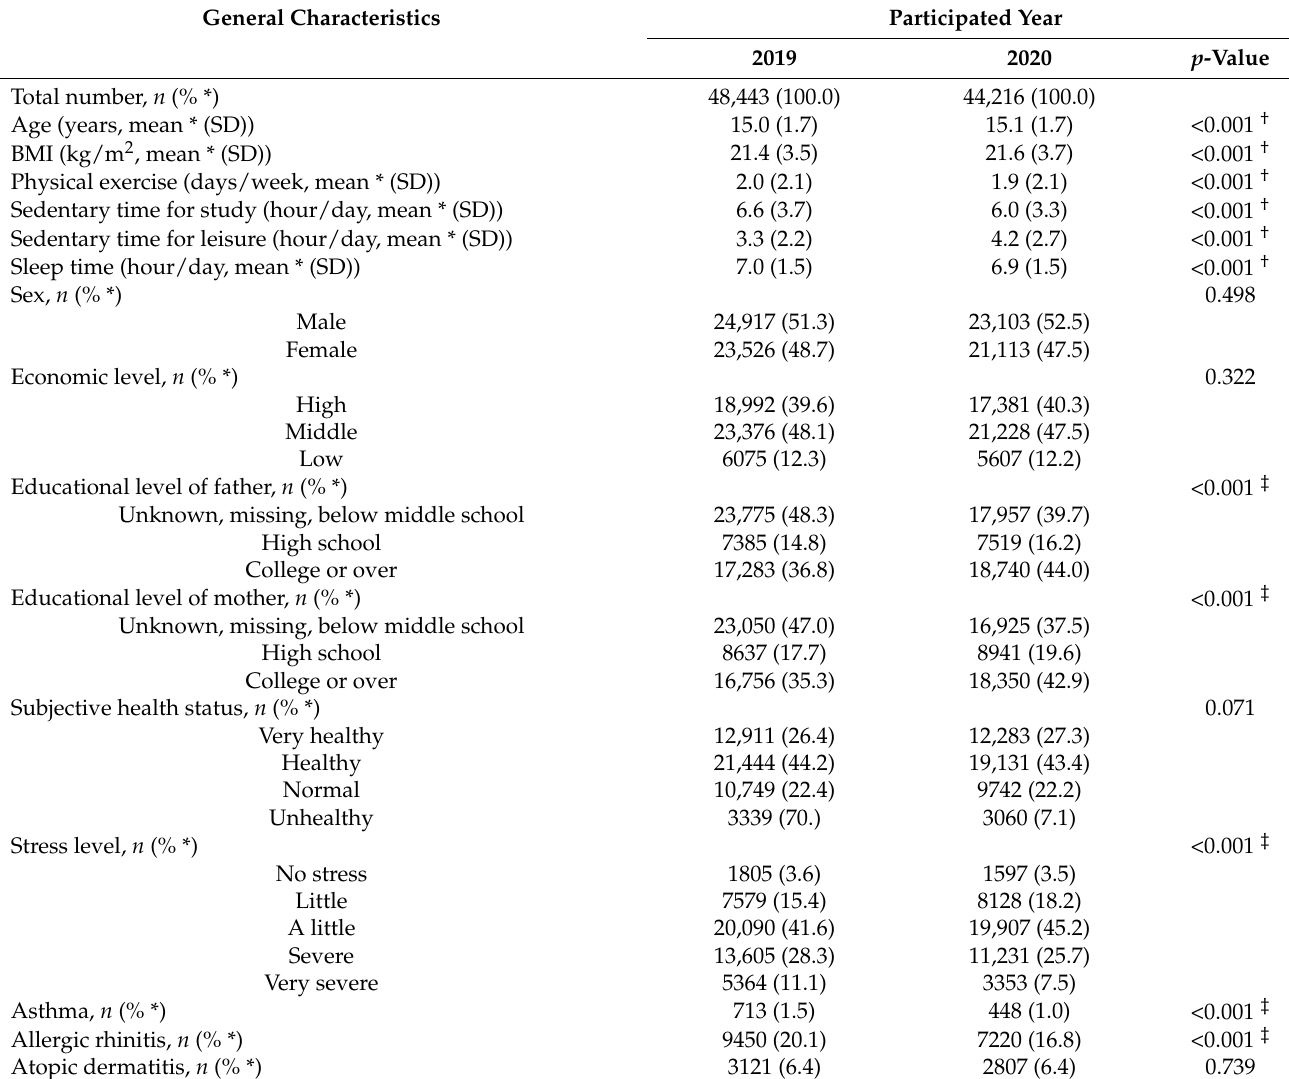
Table 1. General characteristics of